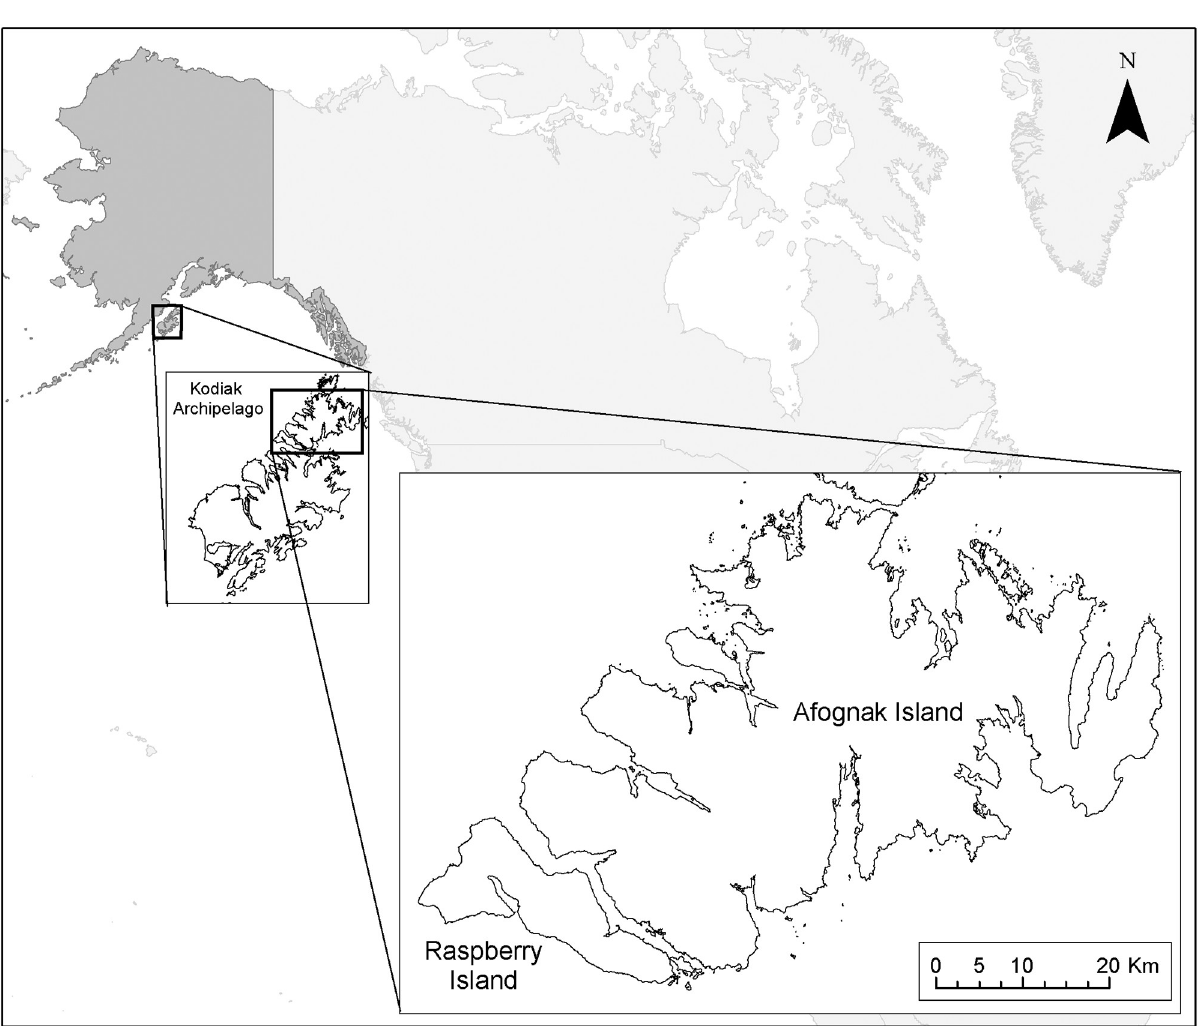
Fig 1. Afognak and Raspberry islands, Alaska, USA. World and state map outlines from NASA open data portal. Afognak and Raspberry islands outline from the Kodiak Island Borough maps and data center.